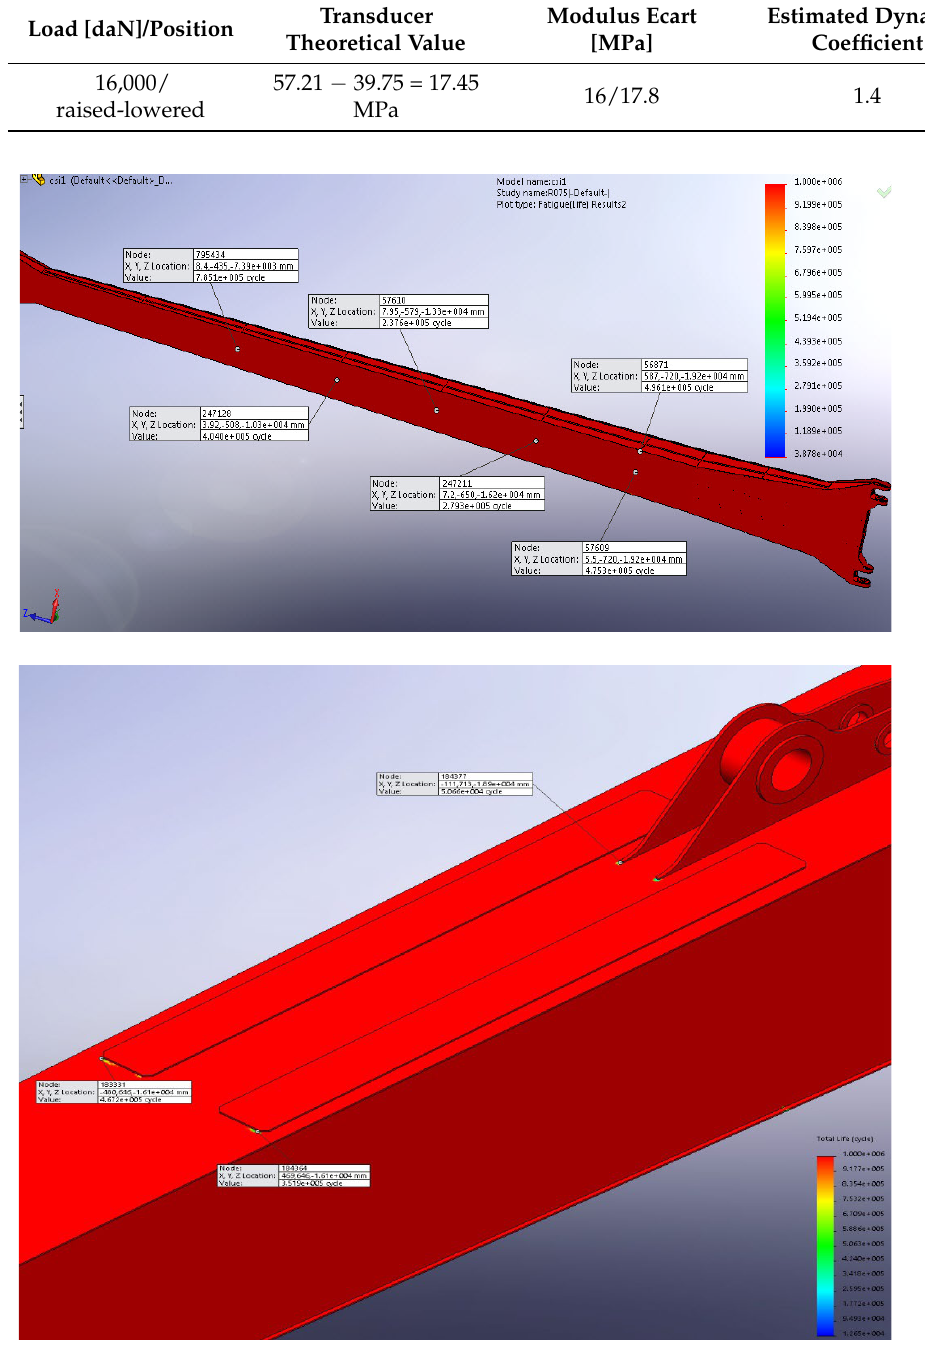
Table 3. Data obtained for the dangerous section of the main section.